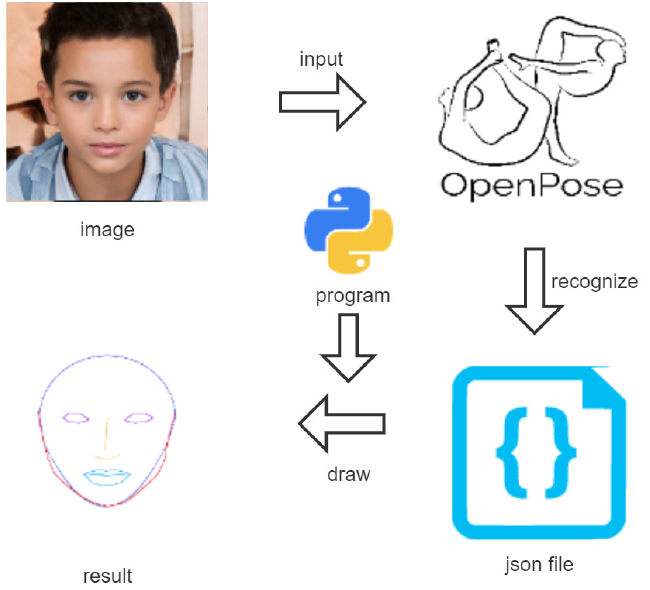
Figure 9. Face contour model generation